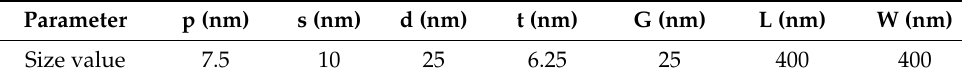
Table 1. Initial geometries of the combline graphene layer embedded for perfect absorber.